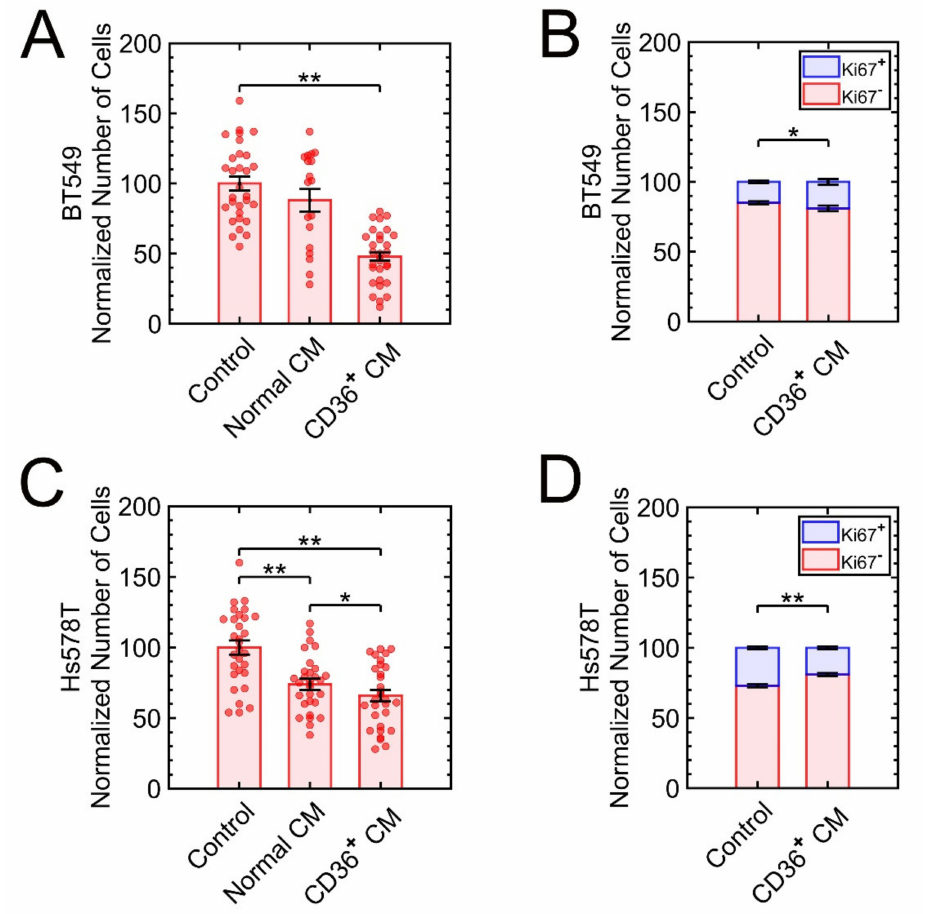
Figure 2. The 3D growths of BT-549 and Hs578T are suppressed as a result of exposure to the CM from CD36 + FBs. ( A , B ) The numbers of cells for BT549 and the frequencies of high versus low expressing Ki67 cells are quantified. ( C , D ) The numbers of cells for Hs578T and the frequencies of high versus low expressing Ki67 cells are quantified. Quantitative data were normalized to control (untreated cells). * p < 0.05, ** p <